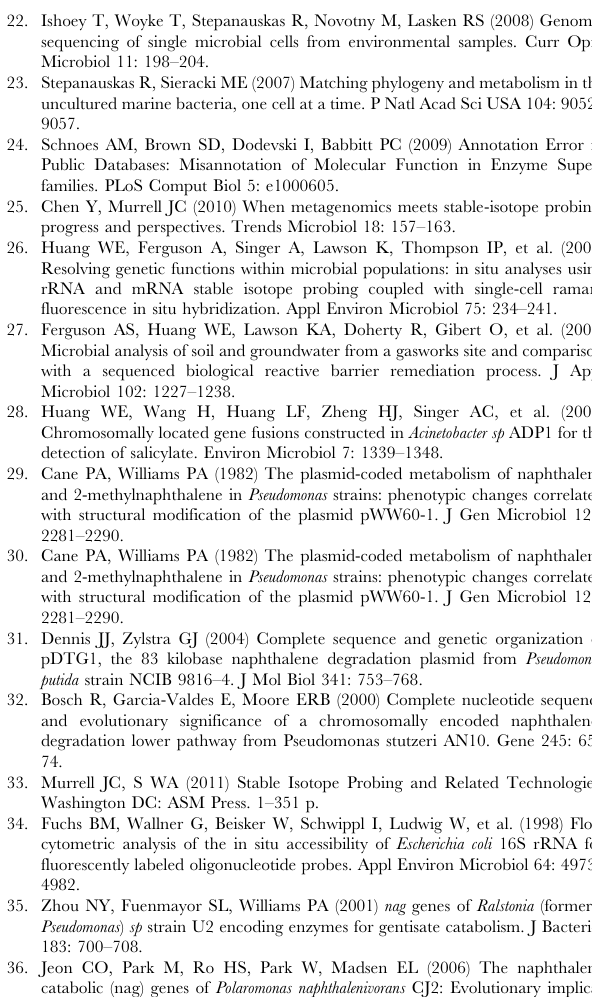
Figure S4 16S-rRNA DGGE analysis of the microbial communities in 13 C- and 12 C-enriched DNA. Two duplicate experiments (1 & 2) were performed. F stands for different fractions after SIP separation. The most intense bands B, present in the 13 C-DNA but not in the 12 C-DNA (labelled B1, B2 and B3), were excised, re-amplified, and sequenced. The result revealed its affiliation with Acidovorax sp. and was designated as Acidovorax sp. WH. (PDF) Figure S5 Phylogenetic tree of some classified 16S rRNA sequences in the 12 C- and 13 C-DNA fractions. Species relative abundance of the total 16S-rRNA reads is shown as %. (PDF) Figure S6 Multi-sequence alignment of the nag operons, including nag2 , nag -U2 and nag- CJ2. Bases which were not the same between nag2 , nag -U2 and nag- CJ2 are colored. Grey highlight represents homologous bases between nag2 and nag -U2, but different from nag -CJ2; Red highlight represents homologous bases between nag2 and nag -CJ2, but different from nag- U2; Blue highlight represents bases of nag2 with no homologies with either nag -CJ2 or nag -U2. The DNA sequence of nagFCQED is from the plasmid pWH_NagFCQED. Bases from single 454 sequencing read are underlined and marked alongside each gene. The